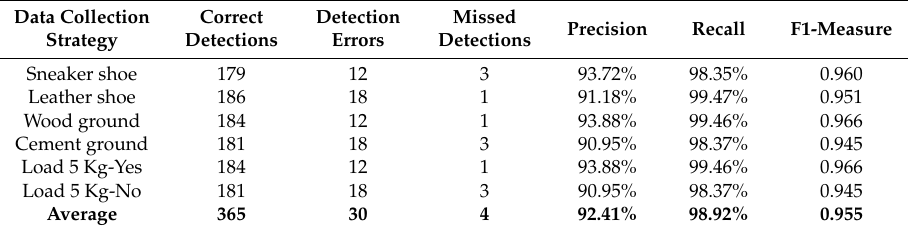
Table 4. Footstep detection results.